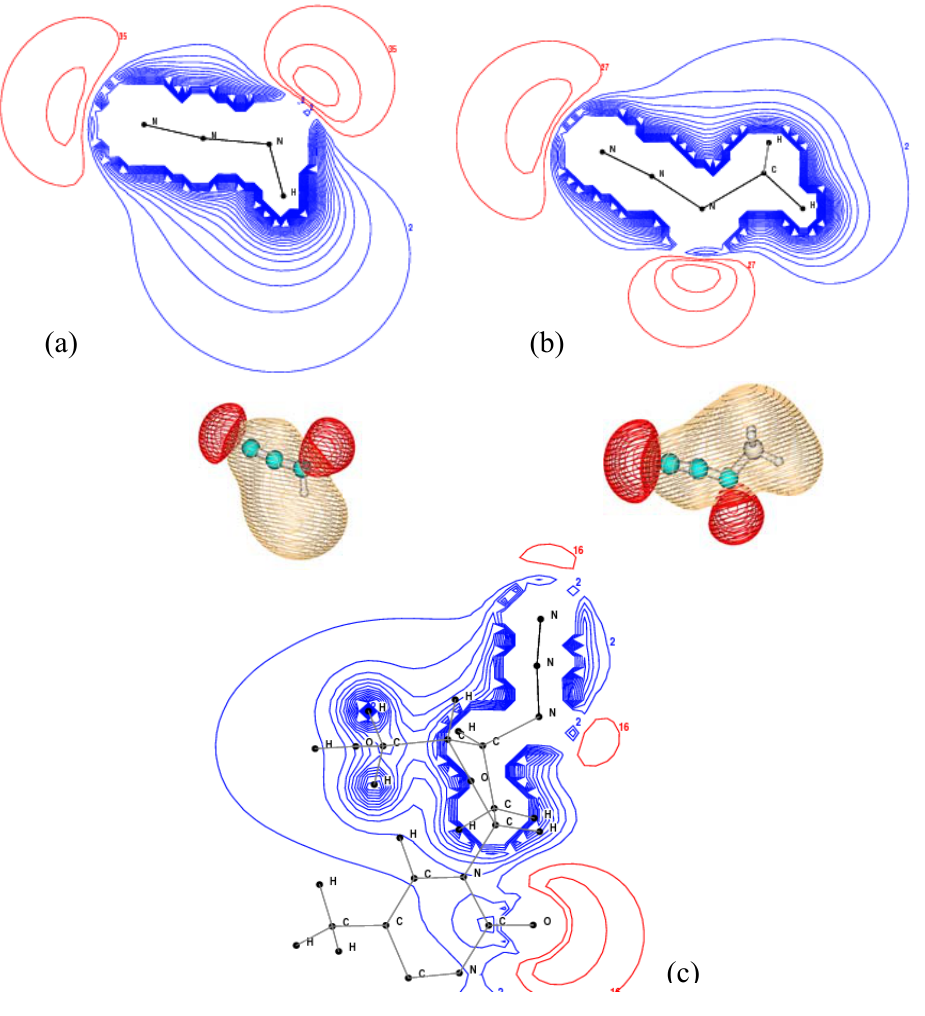
Figure 2. Molecular electrostatic potentials (MEPs) of (a) HN